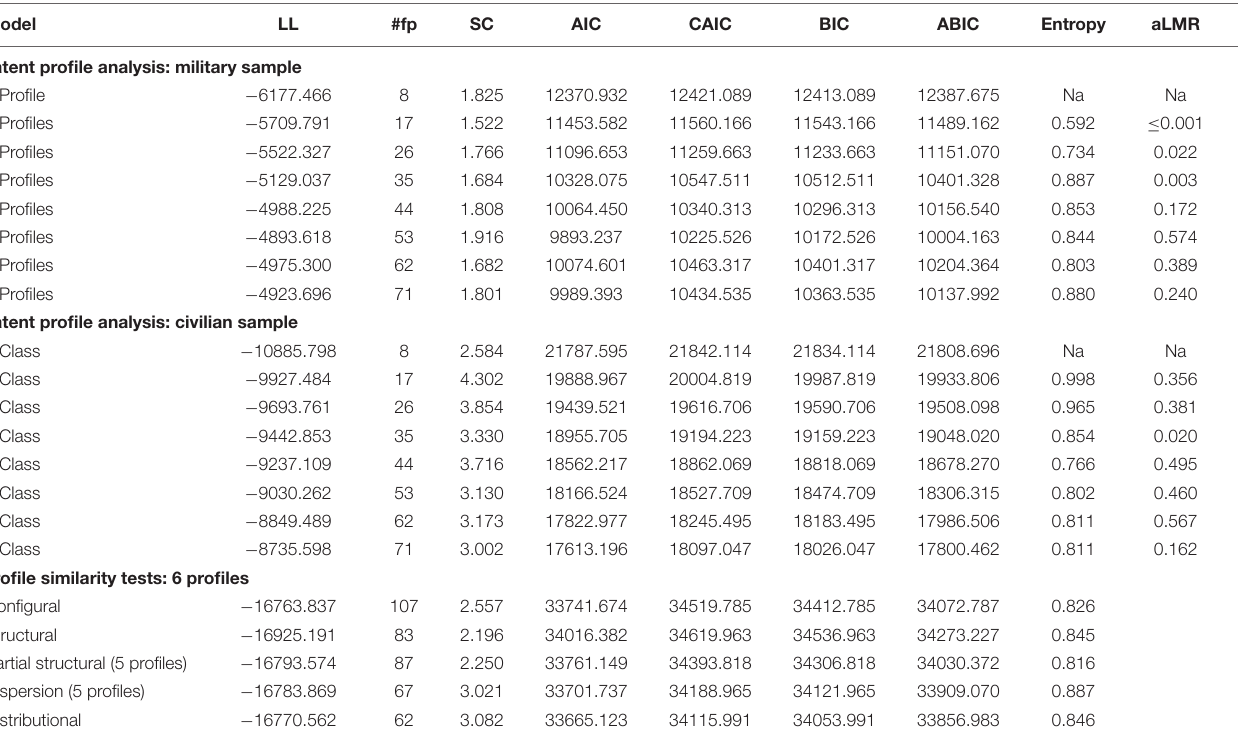
TABLE 1 | Results from the latent profile analyses for each group and tests of profile similarity.